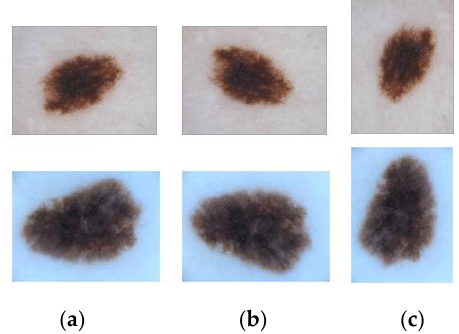
Figure 7. ( a – c ) are the results of the original, vertical flip, and transposition of the two images, re- spectively. Table 2. Details of the medical segmentation datasets used in our